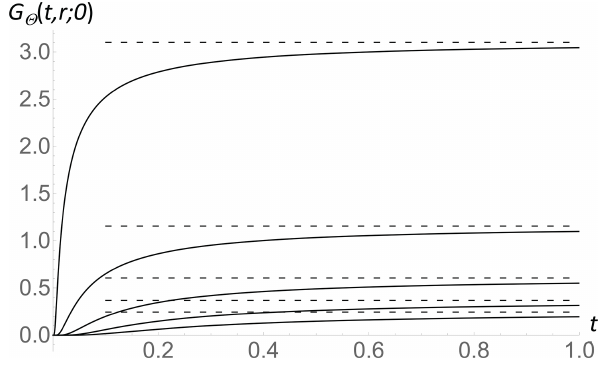
Figure 2. The surface step response (time) and Dirac (space) func- tion ( G (cid:50) ( t,r ; 0), Eq. 12) as a function of nondimensional time; each curve is for a different nondimensional distance from the source increasing from r = 0.2 (top) to r = 1 in steps of 0.2 (top to bottom). At each distance r , the temperature approaches equilib- rium ( = G therm ,δ ( r ), Eq. 21) at large t (shown by dashed horizontal lines).